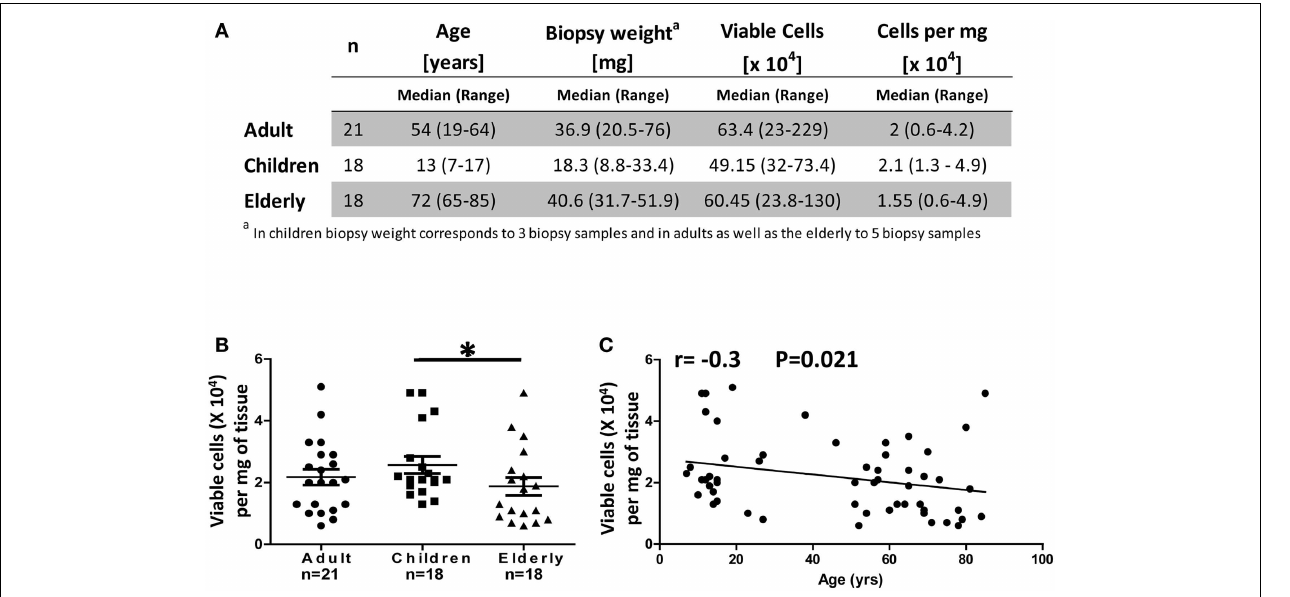
milligram of tissue and compared between the three age groups. (C) Correlation between the age of volunteers and cell yields obtained from biopsies as continuous variables. Results were analyzed using Spearman’s correlation ( n = 57); * p <